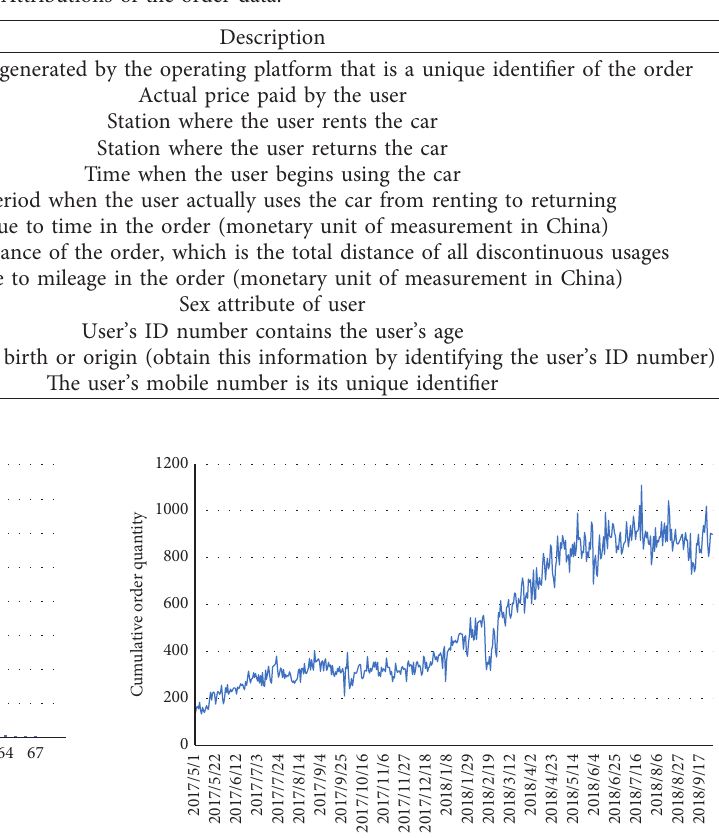
Table 1: Attributions of the order data.